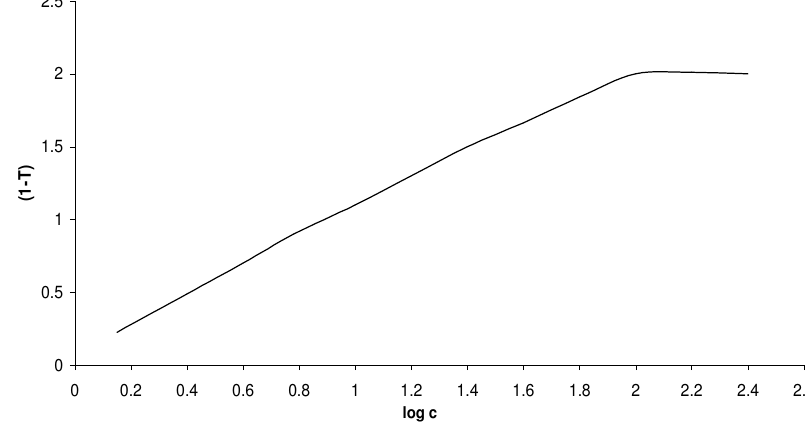
Figure.2 Ring bom's plot for Te(IV) with leuco methylene green